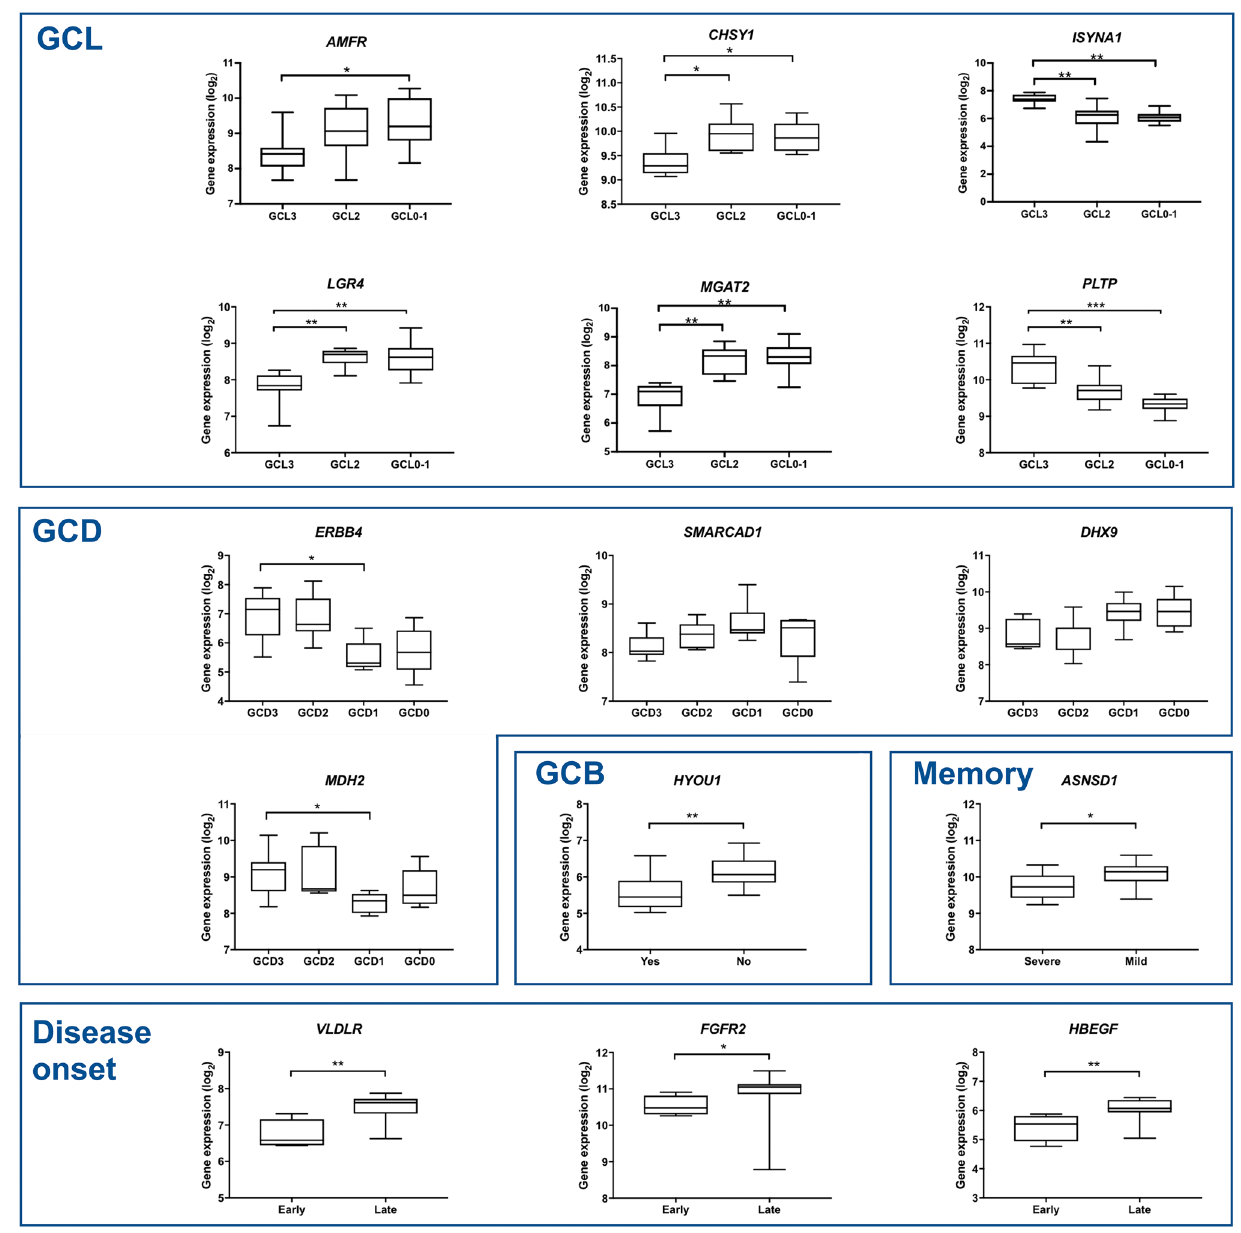
Figure 6. Gene expression plots for the HGS genes highly associated with specific histopathological or clinical data. The abbreviations-GCL, GCD, GCB-refer to histopathological alterations, as described in the Results and Material and Methods sections. Statistical significance values: *P < 0.05; ** P <